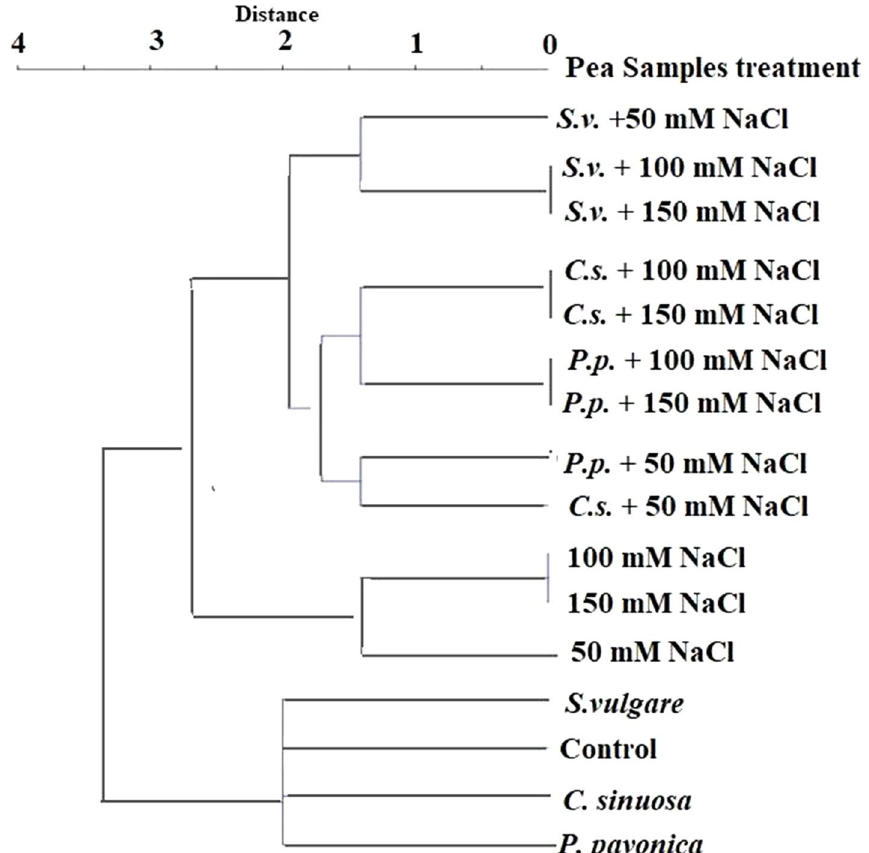
Fig. 3 Cluster tree depicting the differentiation of pea seedlings treated with NaCl (0, 50, 100, and 150 mM), priming with SWEs ( S. vulgare , C. sinuosa , and P. pavonica ) as single or combined treatments based on the variation in SDS‑PAGE protein profile and ISSR DNA